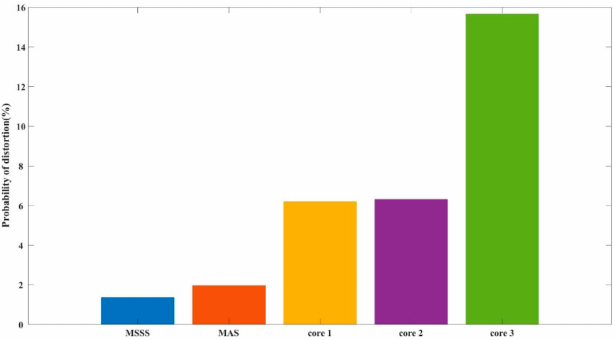
Figure 12. The distortion probability of demodulation